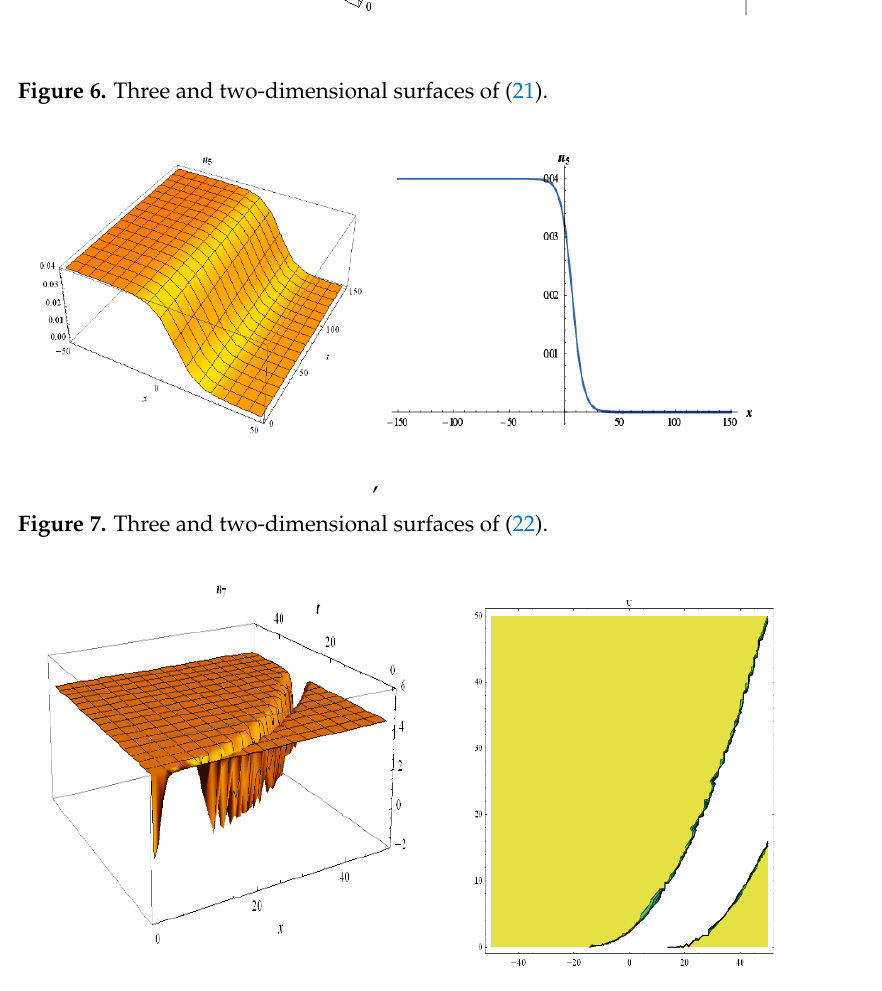
Figure 8. Three-dimensional and contour surfaces of